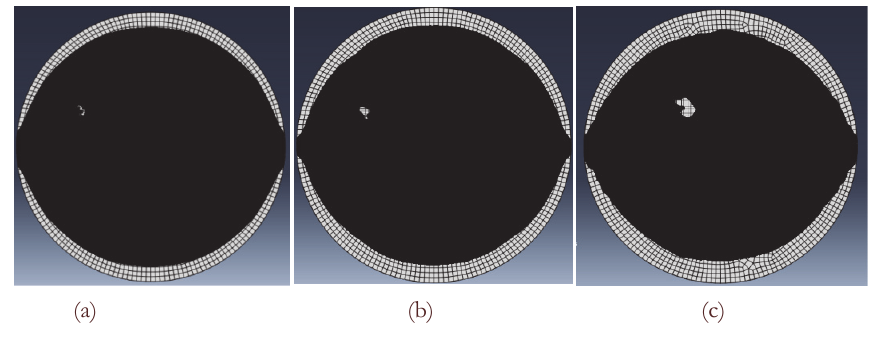
Figure 8: Damaged zone for a circular patch (a) θ = 15 o , (b) θ = 45 o and (c) θ = 75 o .